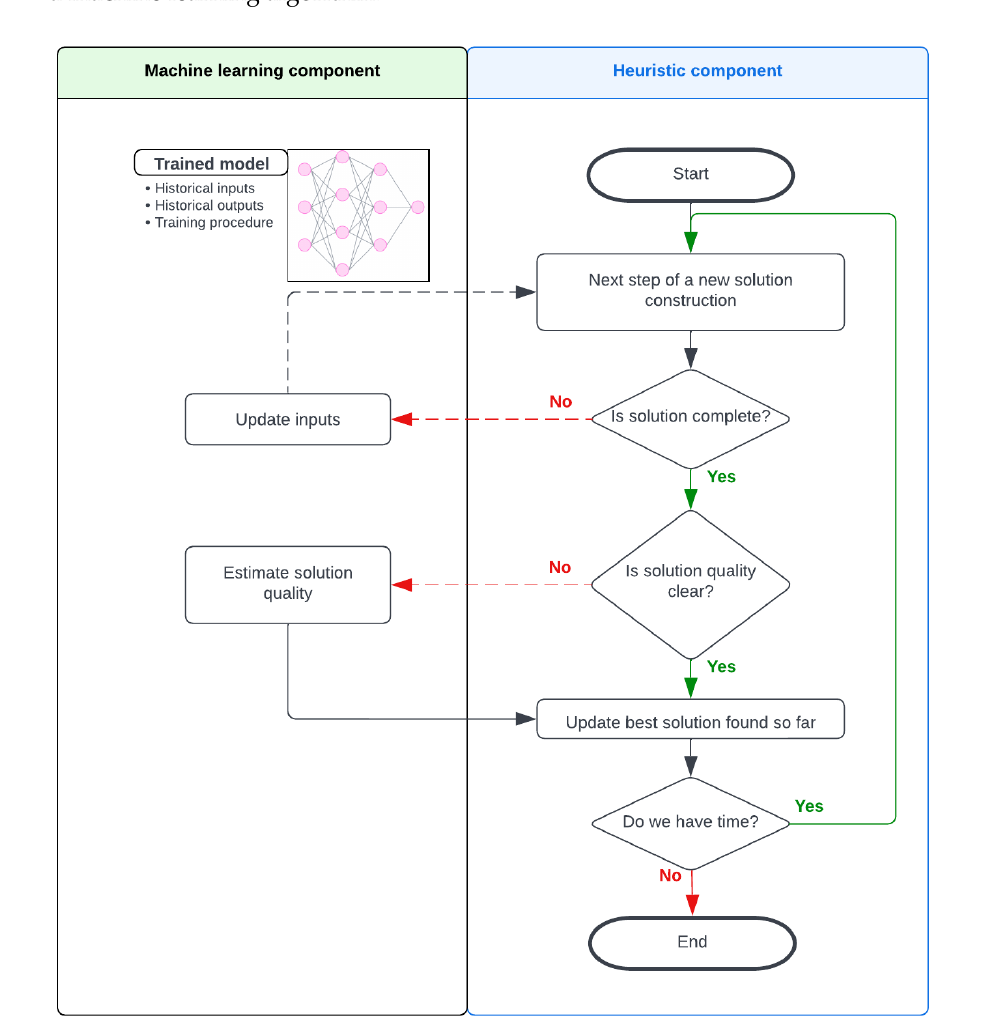
Figure 4. Flowchart of a learnheuristic for the